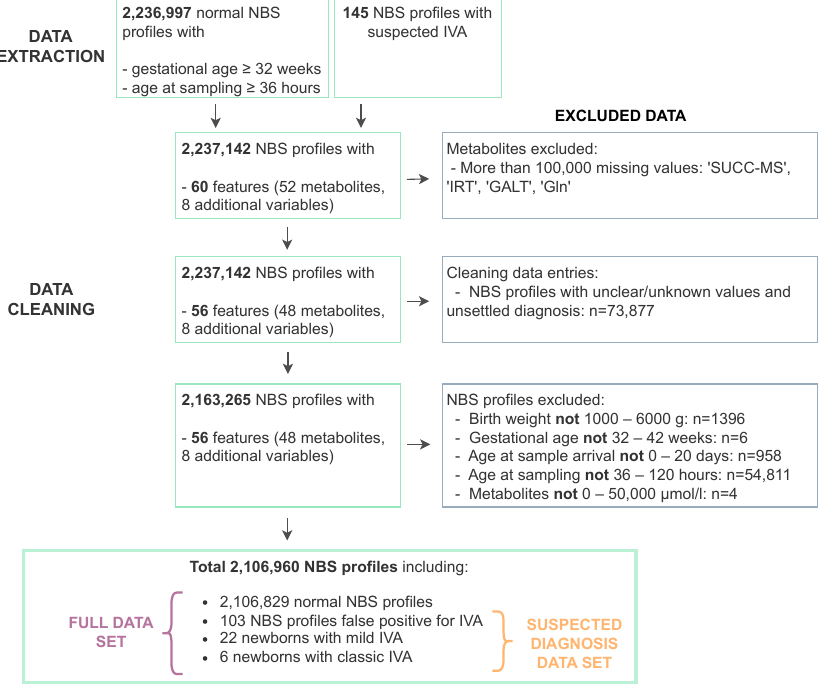
Figure 1. Data extraction and data cleaning flow chart for NBS data screened at the NBS laboratory at Heidelberg University Hospital. NBS profiles from normal and suspected IVA newborns are extracted. From both data sets, features and NBS profiles are excluded due to missing entries and implausible values resulting in 2,106,960 NBS profiles with 60 features including 48 metabolites and 8 additional variables